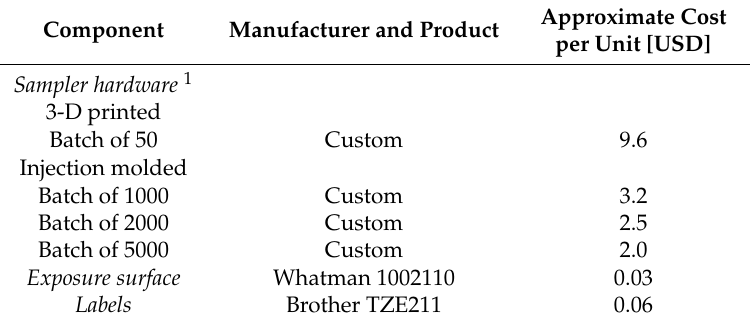
Table A1. Cost estimates for the low-cost passive sampler.